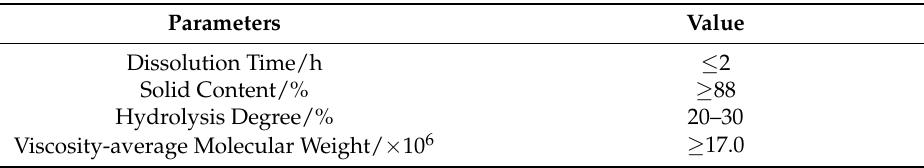
Figure 16. Appearance of CBG. Table 15. Polyacrylamide parameters in